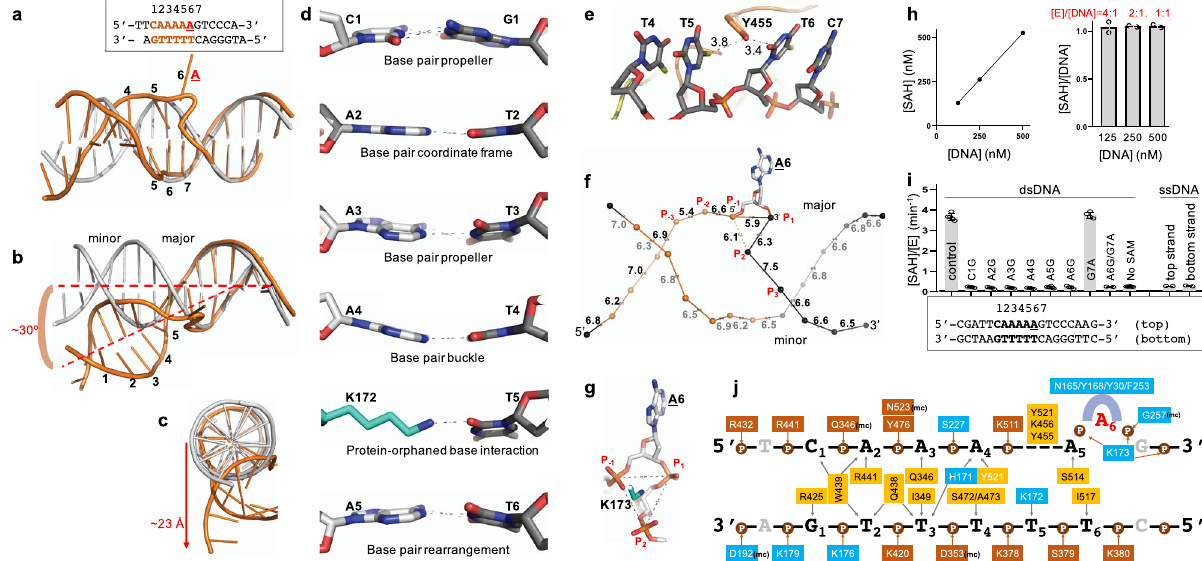
Fig. 3 CamA-bound DNA conformation. a The 6-bp recognition sequence is numbered from 1 to 6. B-form DNA (gray) is superimposed with CamA-bound DNA molecule (orange). Note the fl ipped-out A6 and rearranged base pairs between A5 and T6. b-c Conformational deviations of CamA-bound DNA molecule from B-form DNA. d Conformational differences among the six base pairs of the recognition sequence. e Discontinuous π -stacking between T5 and T6. f Inter-phosphate distances of CamA-bound DNA with the largest variations from three phosphate groups 5 ′ and 3 ’ respectively to the target adenine (P − 3 and P 3 ). g Lys173 sits in the center of equilateral triangle of phosphate groups P − 1 , P 1 , and P 2 . h Under the single turnover conditions where the enzyme is present at or above the DNA substrate concentration, only one methylation event occurs ( N = 2). Enzyme concentrations used are within a linear range (left). Source data are provided as a Source Data fi le. i Effects of single-base pair substitutions. No activity was observed for ssDNA, using the unsubstituted and unannealed strands separately. Data represent the mean ± SD of N number of independent determinations ( N = 5 for control, N = 4 each for C1G, A2G, A3G, A4G, A6G, and G7A substitutions, N = 6 each for A5G and No SAM control, and N = 2 each for A6G/G7A and ssDNA substrates) performed in duplicate. Source data are provided as a Source Data fi le. j Schematic illustration of CamA-DNA interactions (for an enlarged version, see Supplementary Fig. 6b): residues in cyan background are from the N-terminal catalytic domain, and residues in (light and dark) orange from mc, main-chain-atom-mediated